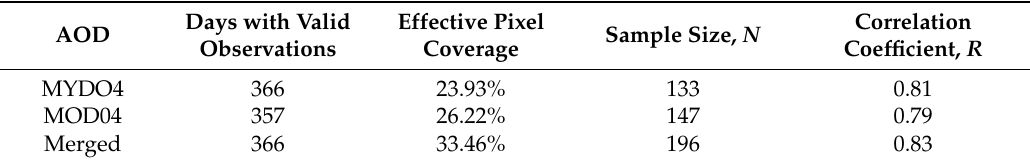
Table 1. Statistics of satellite-based aerosol optical depth (AOD) and merged AOD